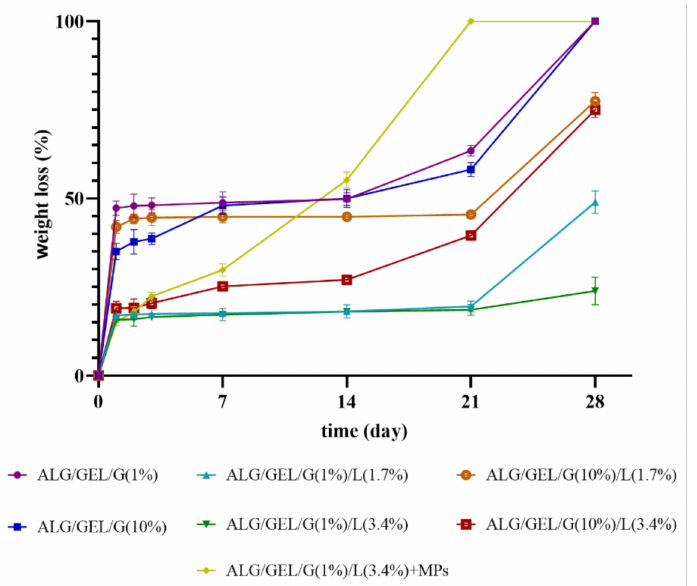
Figure 7. The values of weight loss during the degradation of cross-linked lyophilized emulsions based on sodium alginate and gelatin with different amounts of glycerol compared to the control samples (without lipids), as well as a sample with incorporated PLA